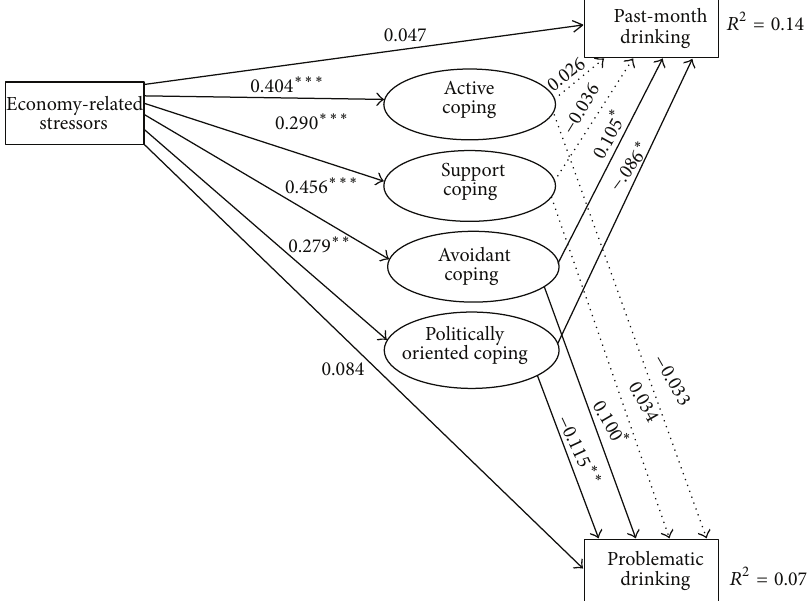
Figure 3: Structural equation model relating economy-related stressors to coping strategies and alcohol-related outcomes.